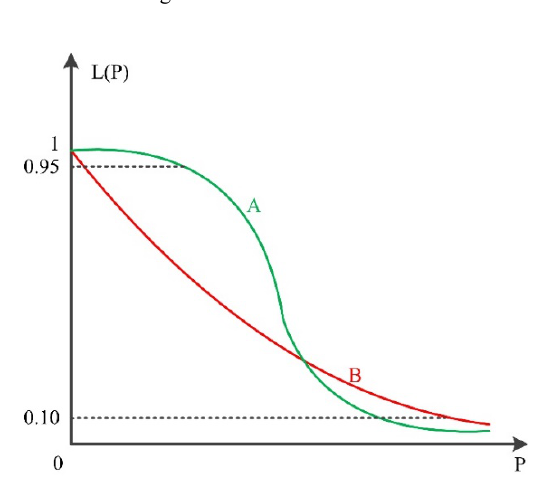
Figure 5. The Ideal OC Curve